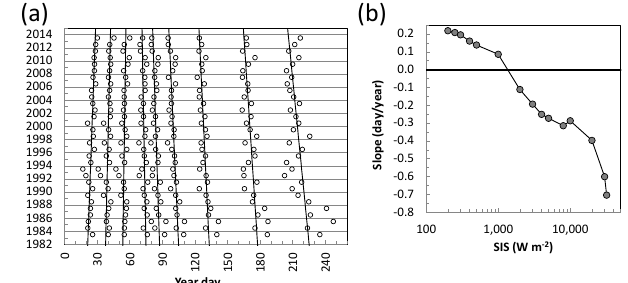
Figure 3. Changing seasonality in cumulative surface incoming shortwave irradiance (SIS,Wm − 2 ) averaged over the area of the Baltic Sea indicated in Fig. 1a. (a) DFCUMSIS – i.e., day of year when the annual sum of daily mean SIS reaches the following thresholds: 200, 500, 1000, 2000, 3000, 5000, 10000, 20000 and 30000Wm − 2 . For each threshold the circles show the day of the year and the line shows the respective linear regression. (b) Slopes of the linear regressions in panel (a) .